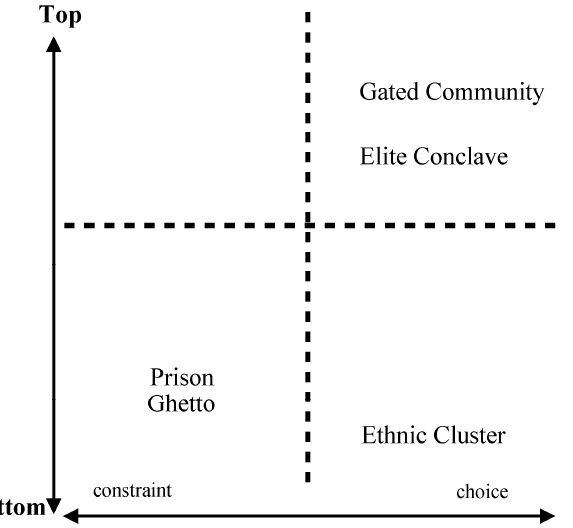
Figure 1. Wacquant’s (2010) typologies of sociospatial seclusion in urban setting as rendered in quadrants and axes.